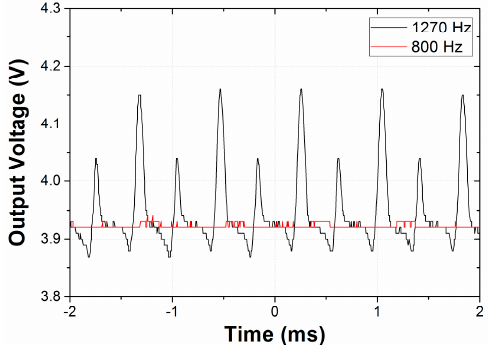
Figure 6. Output voltages from port B in the time domain. The multi-directional energy harvester (symmetrical spring design) is used under a vibration of 6 g with a tilting angle of 0° with respect to the y -axis, an initial polarization voltage of 5 V, and resistance of 0.717 M Ω . At the band of on-resonance (1270 Hz), a voltage peak indicating the energy conversion appears, whereas no significant change is shown at off-resonance (800 Hz.)